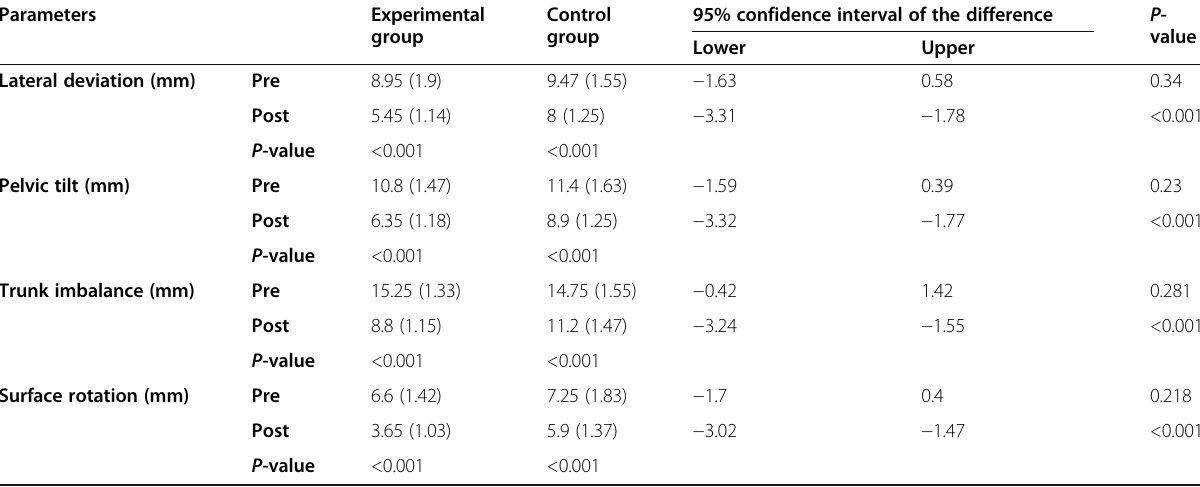
Table 2 Pre- and post-treatment mean values of lateral deviation, pelvic tilt, trunk imbalance, and surface rotation within each group and between groups